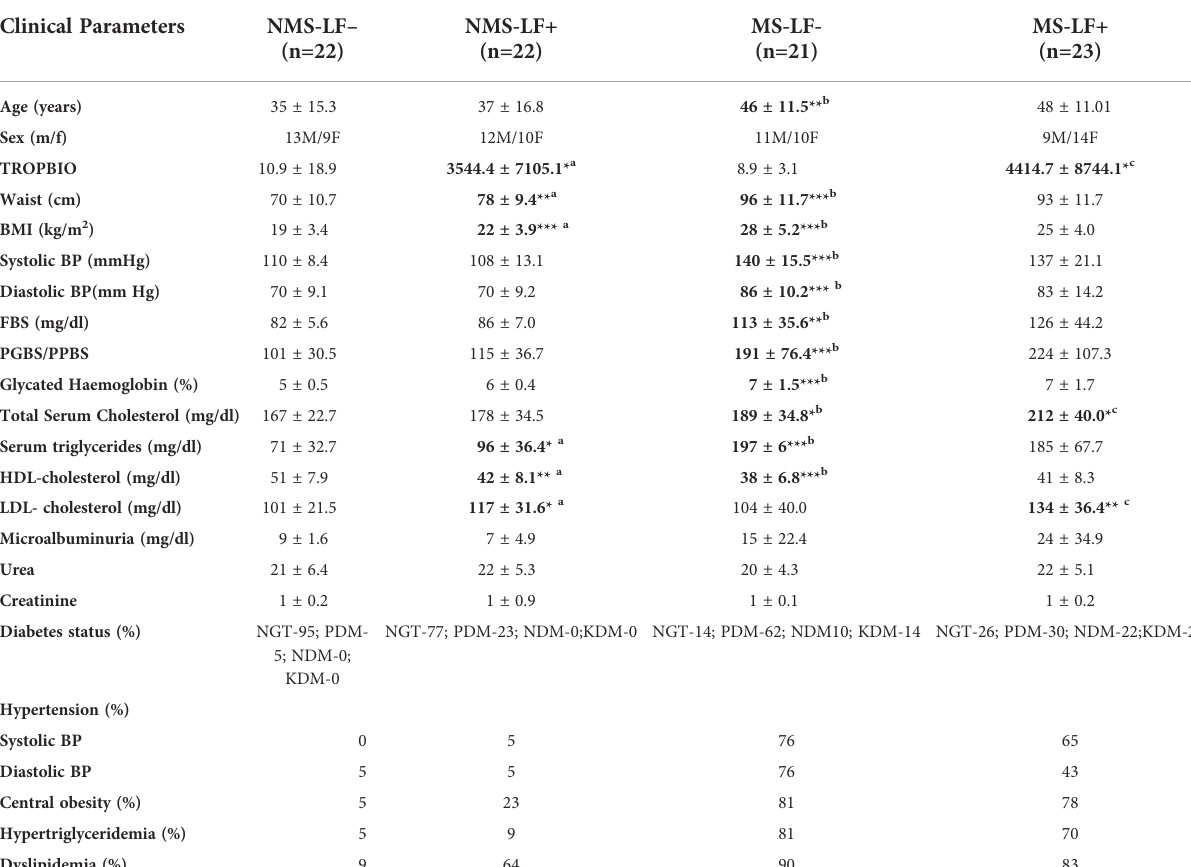
TABLE 1 Clinical characteristic of the study groups. Clinical